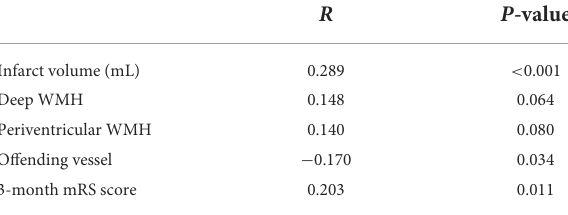
TABLE 3 The Spearman correlation between APVS grade and risk